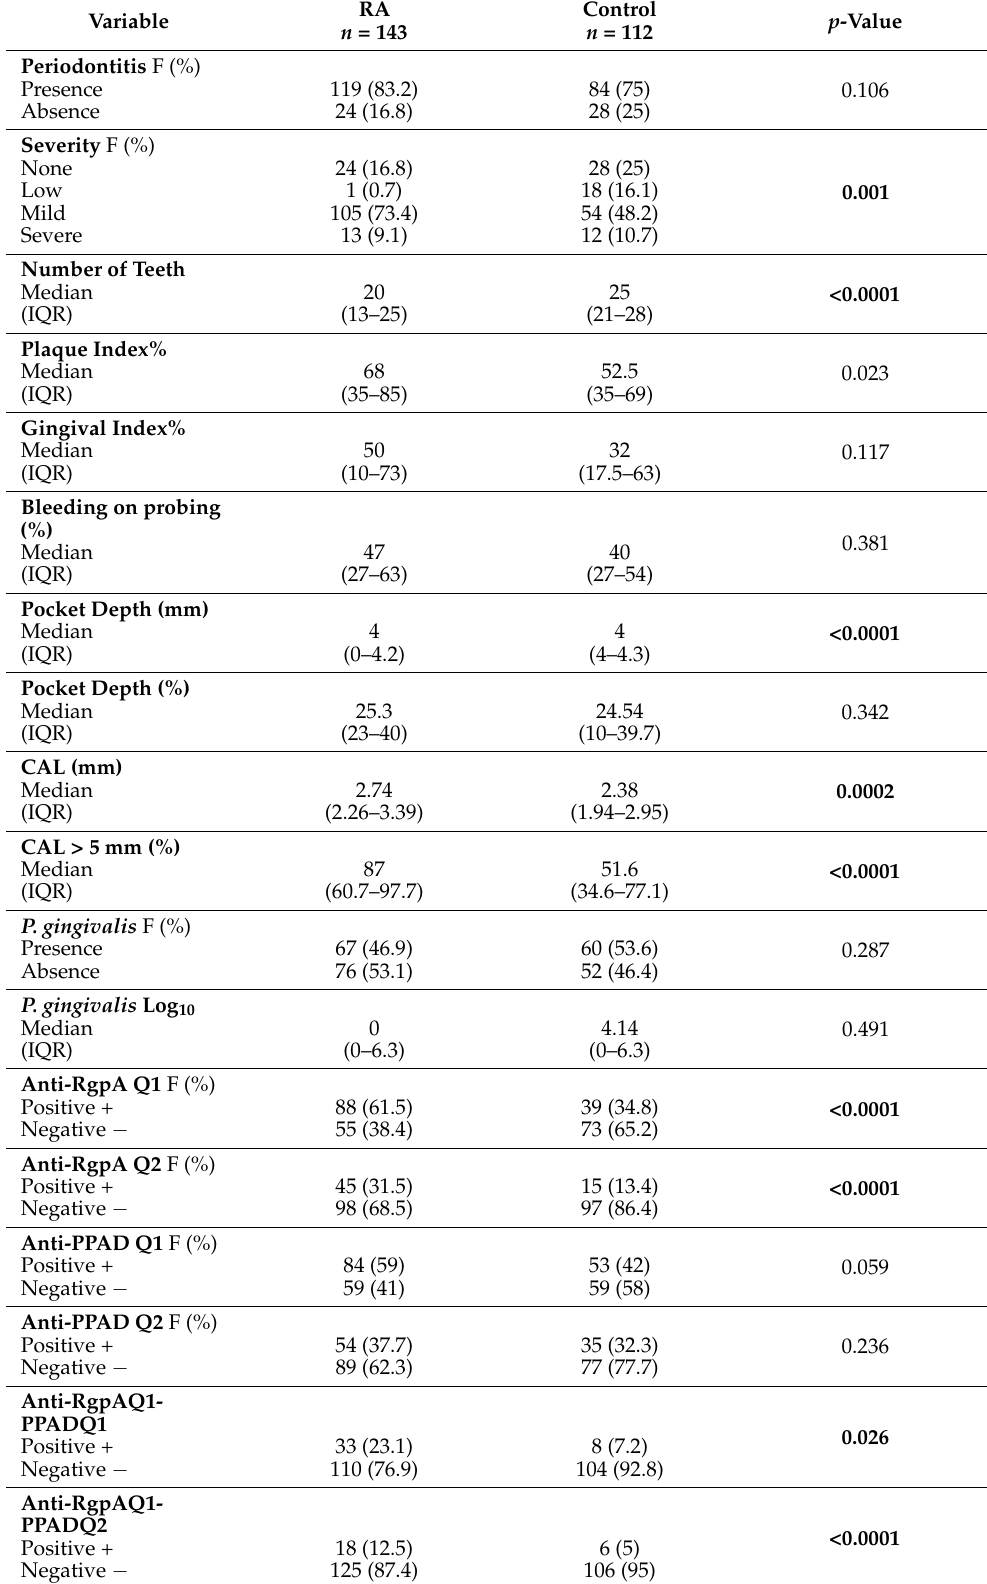
Table 2. Description of periodontal clinical and microbiological variables associated with